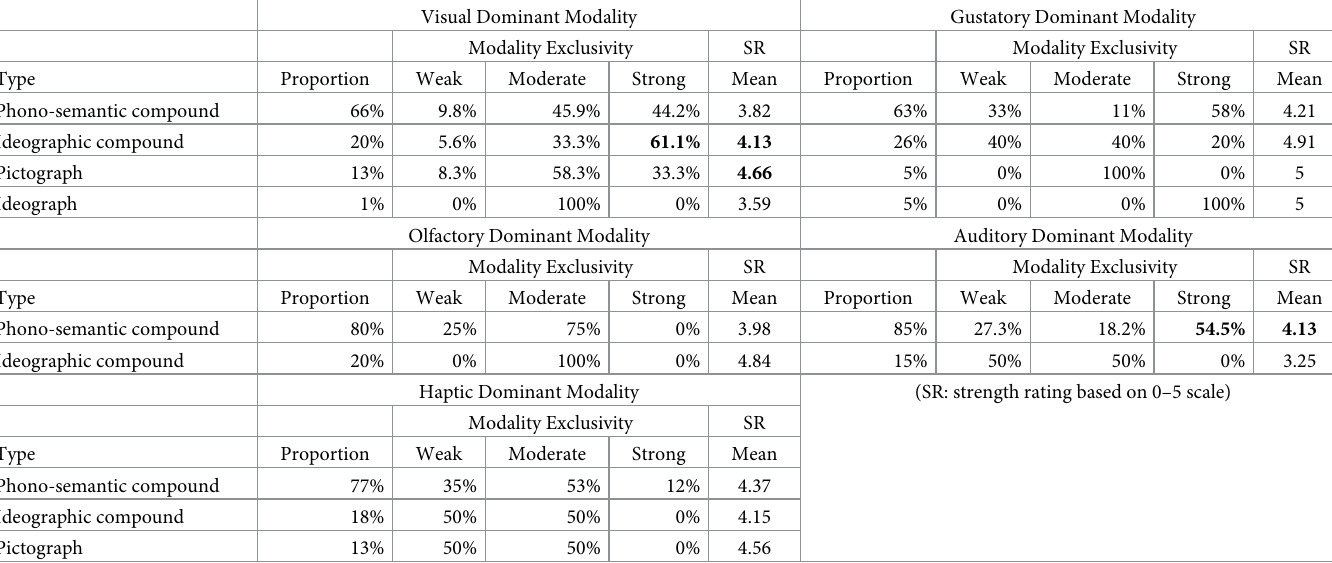
Table 5. Six types of characters in the five dominant